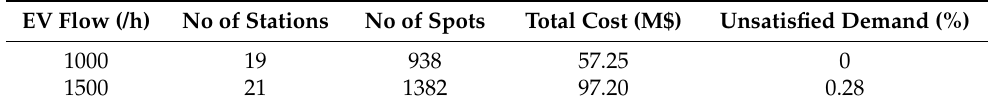
Table 5. Summary of the planning results of SS